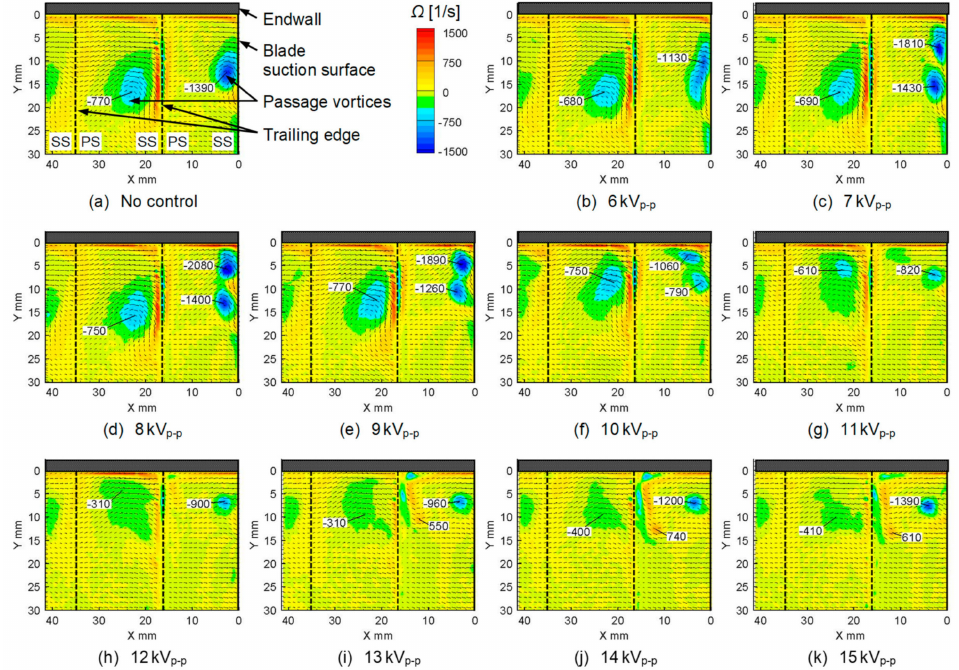
Figure 19. Vorticity distributions at the outlet of the linear turbine cascade at various input voltages ( U FS , out = 4.7 m /